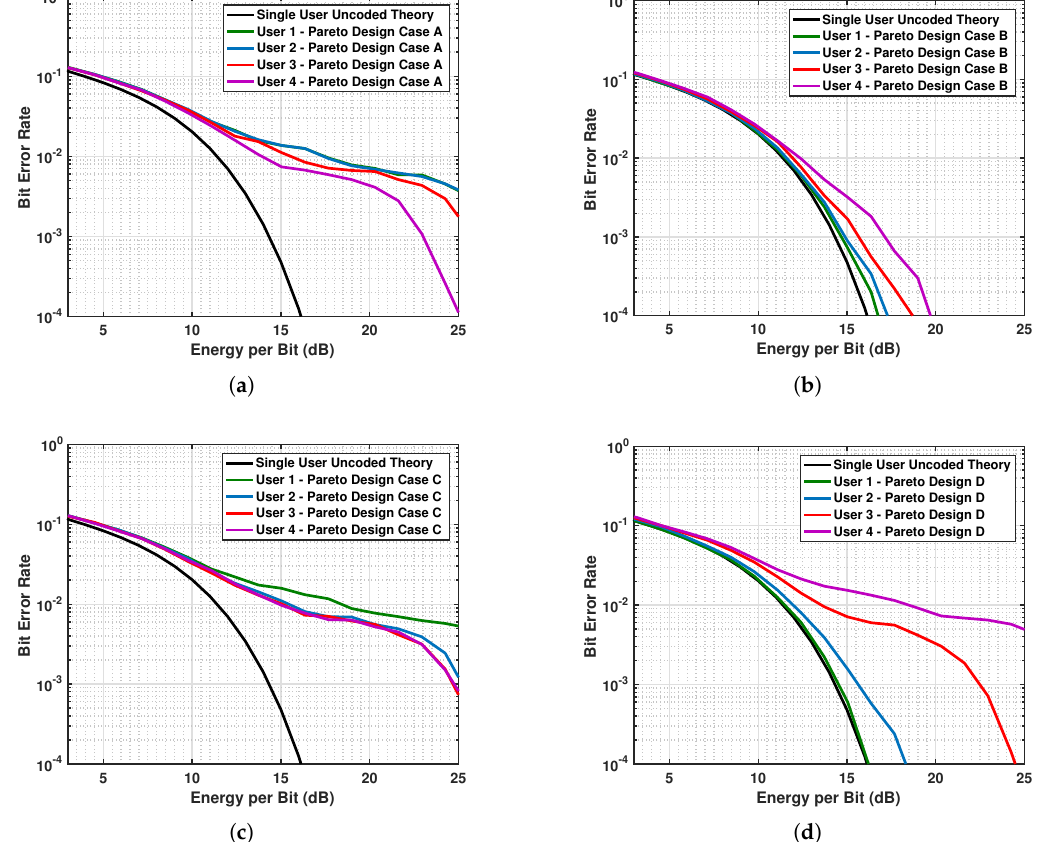
Figure 11. Four communications users BER performance using the Pareto designs: ( a ) A; ( b ) B; ( c ) C; and ( d )